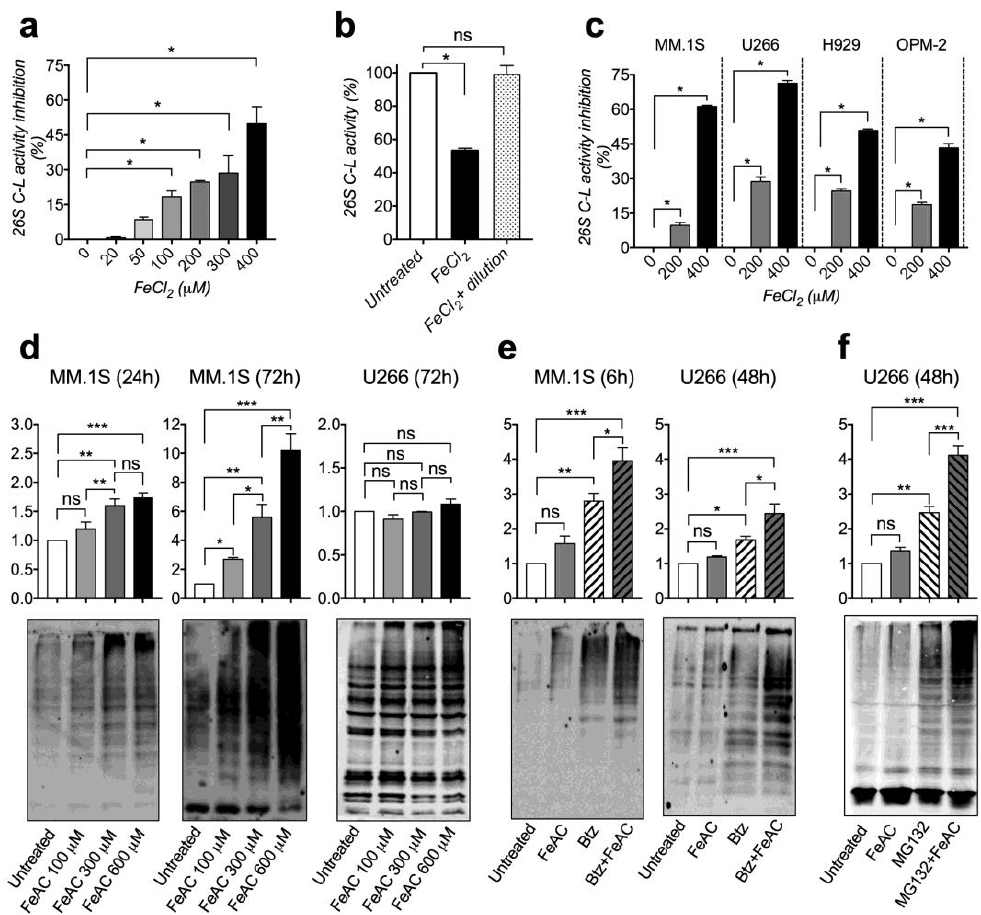
Figure 2. Iron impairs proteasomal activity and causes polyubiquitinated proteins accumulation. ( a , b ) Evaluation of chymotrypsin-like (C-L) activity of purified 26S proteasome after pre-incubation with titrated doses of ferrous chloride (FeCl 2 ) for 5 min. ( a ) Data show the percentage of C-L activity inhibition. ( b ) Data show residual C-L activity after pre-incubation with 400 µ M FeCl 2 followed or not by iron dilution prior to C-L activity evaluation. ( c ) Evaluation of proteasomal C-L activity of multiple myeloma (MM) cellular extracts after pre-incubation with titrated doses of FeCl 2 for 5 min. Background activity (caused by non-proteasomal degradation) was determined by addition of 2 µ M epoxomicin and subtracted from total C-L activity. ( d , e ) Polyubiquitinated (Poly-Ub) proteins levels in: ( d ) MM.1S and U266 cells treated with titrated doses of ferric ammonium citrate (FeAC) for 24 or 72 h; ( e ) MM cells treated with 600 µ M FeAC or 10 nM bortezomib (Btz) or combination for 6 h (MM.1S) or 48 h (U266); ( f ) U266 cells treated with 600 µ M FeAC or 0.5 µ M MG132 or combination for 48 h. Upper panels: summary of densitometry of at least 3 independent experiments (Fold relative to untreated). Lower panels: Representative western blotting. Values are shown as mean ± standard errors. ( a – c ) Statistical di ff erences were determined by nonparametric Mann-Whitney U test. ( d – f ) Statistical di ff erences were determined by Tukey post-ANOVA test. ns: non-statistically significant. * p < 0.05; ** p < 0.01. *** p <0.001.